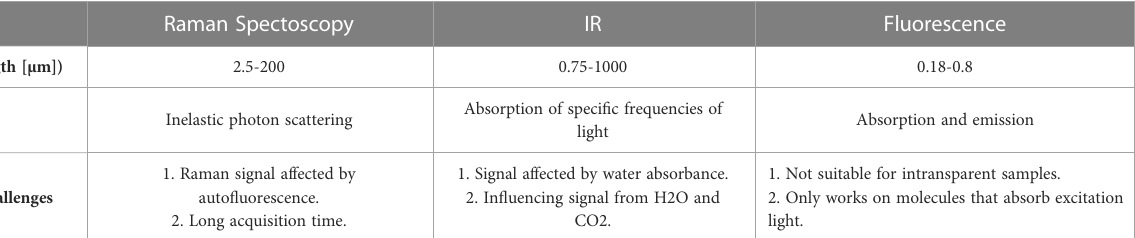
TABLE 1 Characteristics of different spectroscopy.